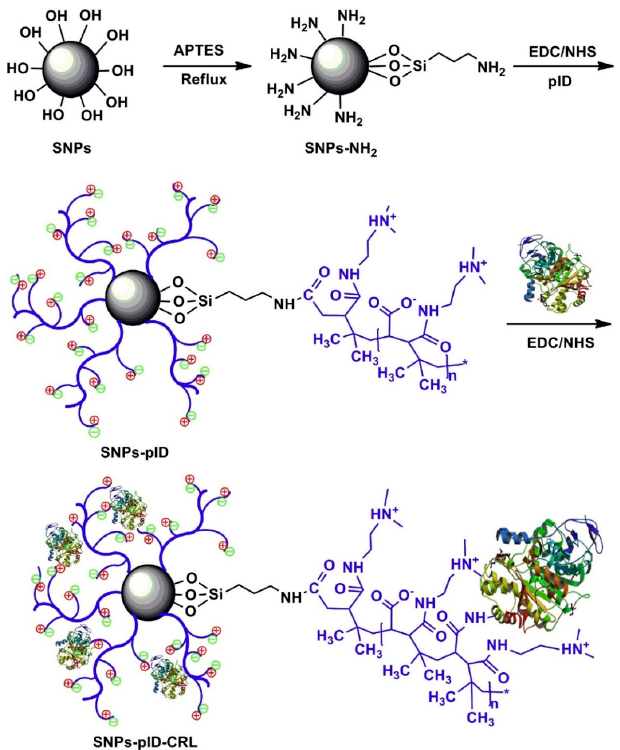
Figure 7. Schematic for the preparation of immobilized lipase on poly(4-((2-(dimethylamino)ethyl)amino)-4-oxobut-2-enoic acid-alt-isobutylene) (pID)-grafted silica nanoparticles. Reprinted from Zhang et al. [63], with permission from Elsevier. Copyright (2019) Elsevier B.V.